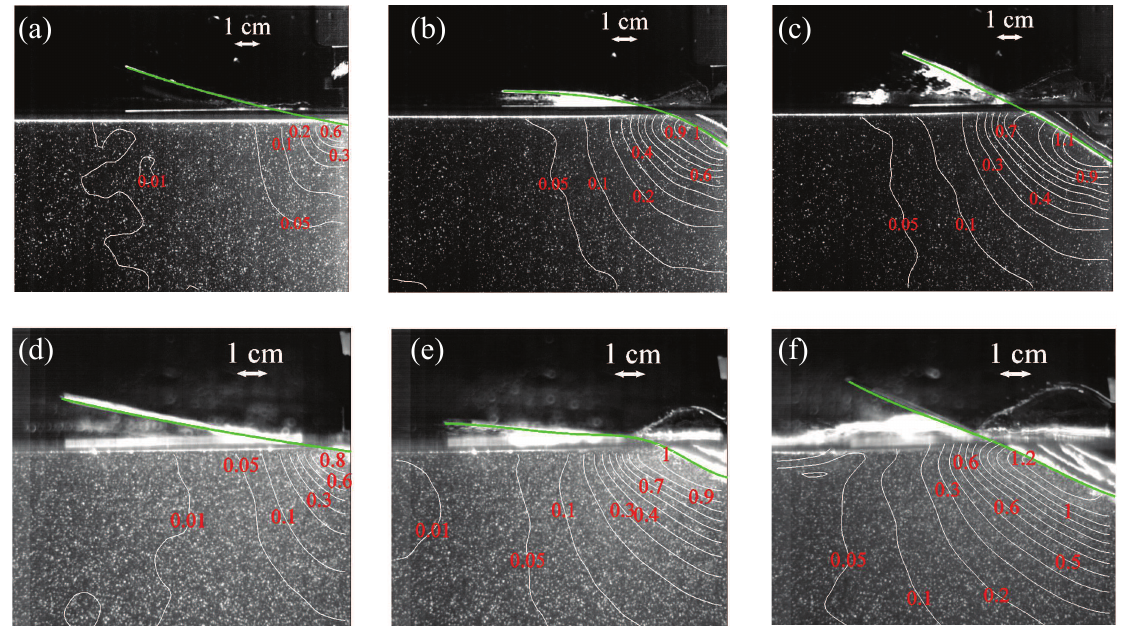
Figure 2. High-speed images overlaid with velocity magnitude in m/s for ( a – c ) Light-Short and ( d – f ) Heavy-Short conditions, at different time instants: ( a , d ) t = 1.25 ms; ( b , e ) t = 7.5 ms; and ( c , f ) t = 12.5 ms. The green line identifies the panel shape.